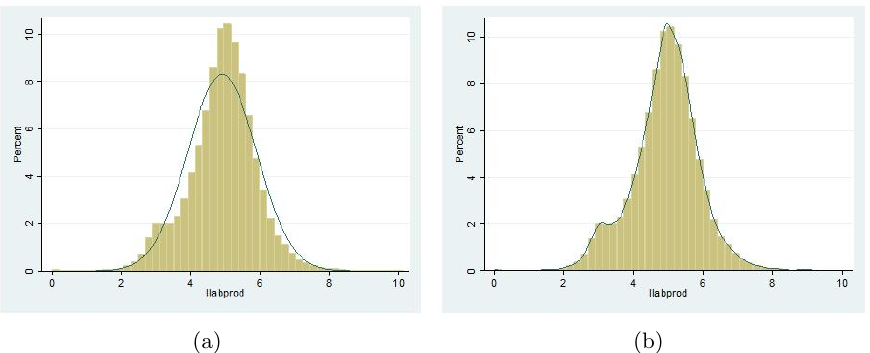
Figure 3 – Histogram and Normal Density Plot (Panel a) and Kernel Density Plot (Panel b) of Labor Productivity (in